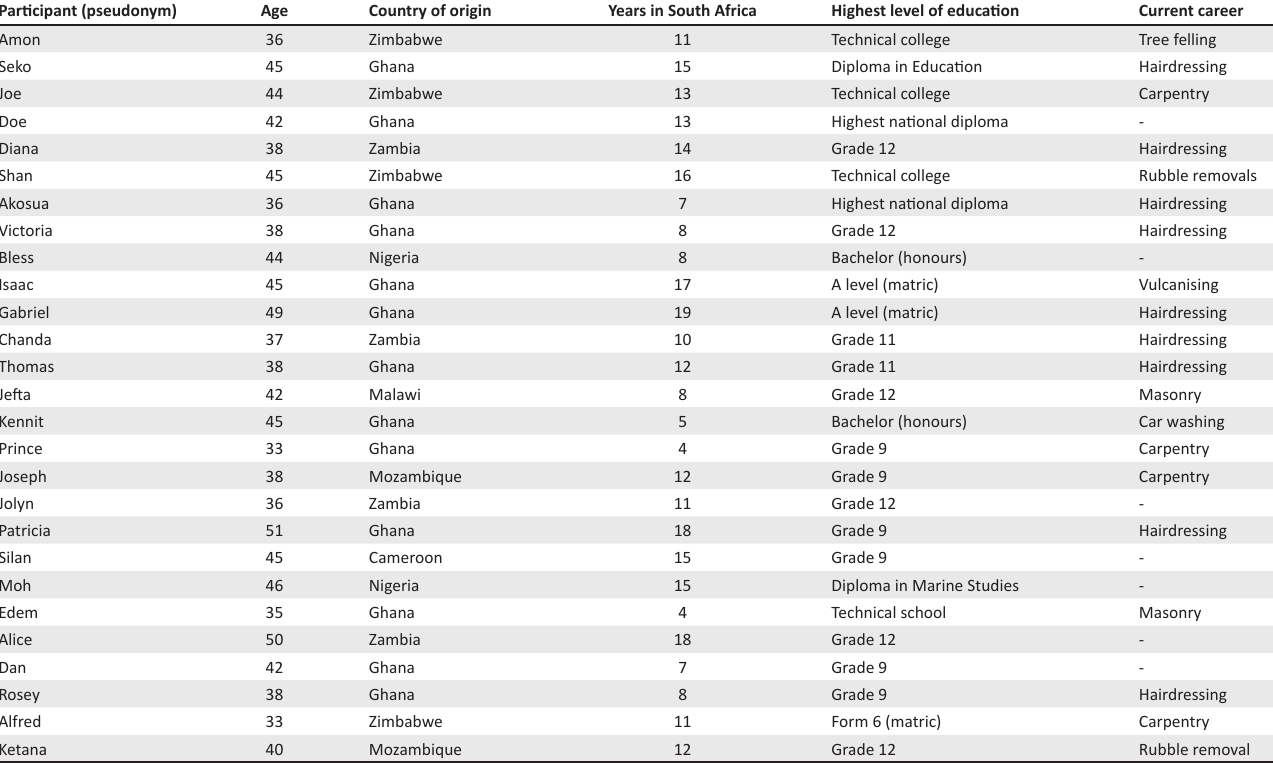
TABLE 1: Participant profiles. Participant